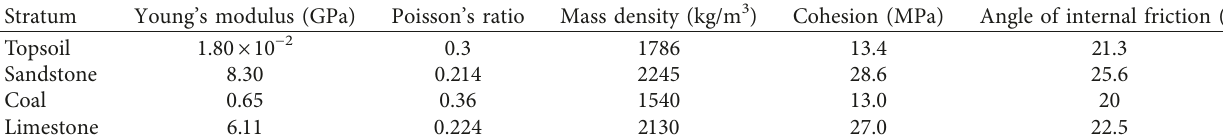
Table 1: Properties of each geologic layer.